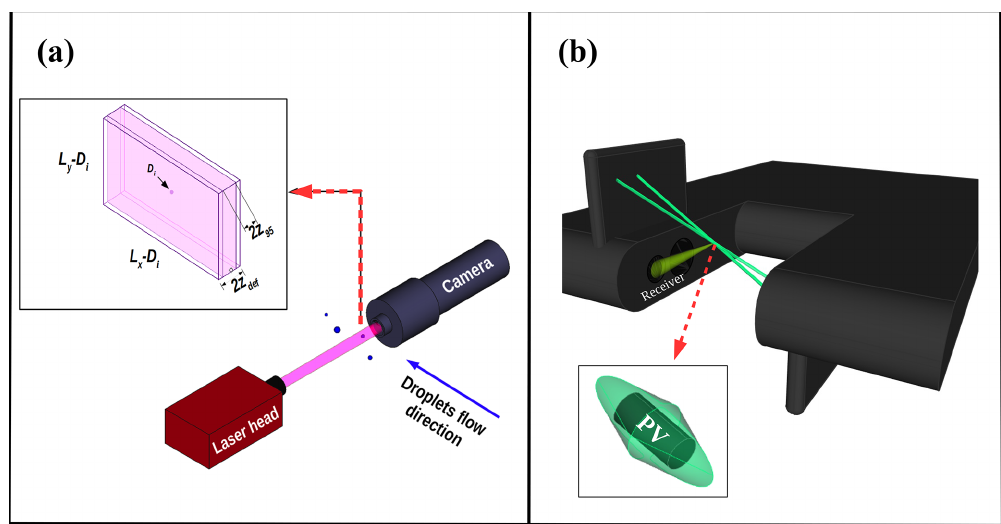
Figure 1. Schematic representation of (a) the VisiSize setup and a magnified SV around a droplet, comparing the default and corrected depth of fields ( z def vs. z 95 ); (b) a PDI probe with the magnified illustration of the cylindrical probe volume (PV) within the intersection of two laser beams where the light from the passing droplets is scattered into the